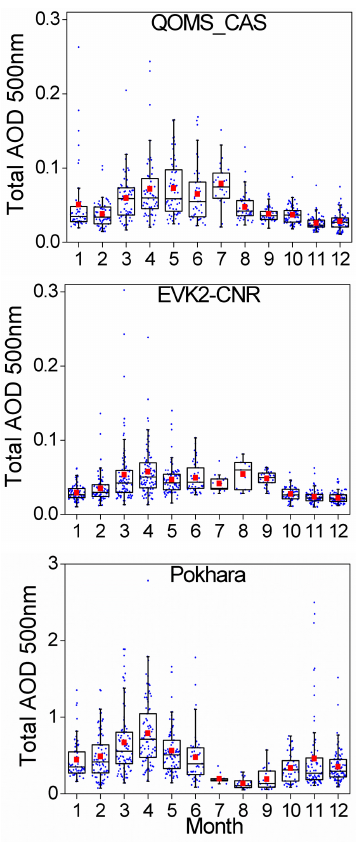
Fig. 3. Box plots of total aerosol optical depth at 500nm at QOMS_CAS, EVK2-CNR and Pokhara. The blue dots represent daily observations. The central bar is the median, and the box shows the first and the third quartiles, respectively. The whisker shows the lower and upper extreme values. The solid red block symbols indi- cate arithmetical means.